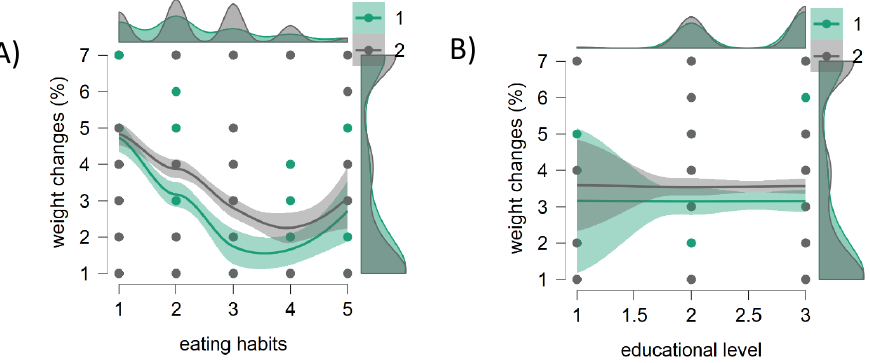
Figure 3. Scatter plots created with JASP (www.jasp-stats.org, accessed on 20 January 2021). ( A ) The x-axis eating habits, y-axis weight changes (%); ( B ) x-axis educational level, y-axis weight changes (%). The lines for the relation between eating habits and weight changes (%) are different for female participants (1 • ), and male participants (2 • ). The relation between educational level and weight changes (%) is flat for both the genders. Eating habits is for the percentage variation of individual eating habits induced by the lockdown (1 = 0–5%; 2 = 5–20%; 3 = 20–50%; 4) 50–80%; 5 = >